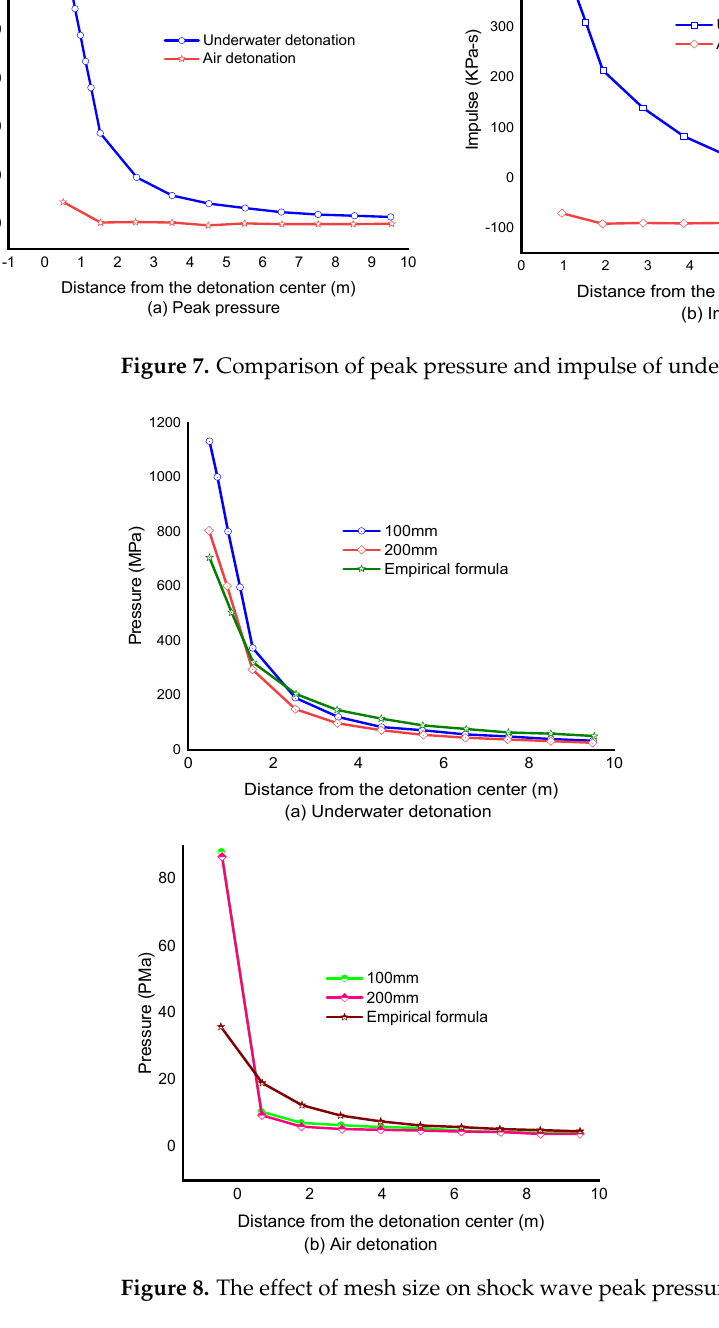
Figure 8. The effect of mesh size on shock wave peak pressure.